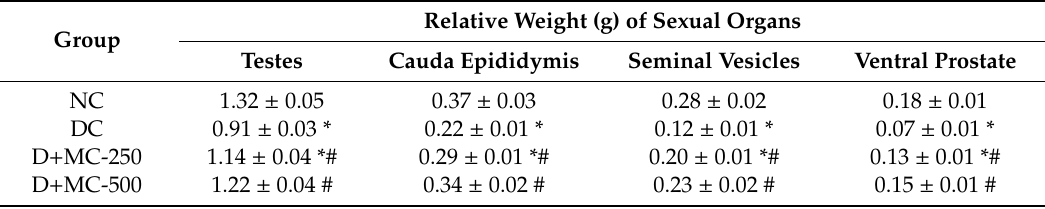
Table 6. E ff ect of MC on relative weight of sexual organs of STZ-induced diabetic male rats. Group